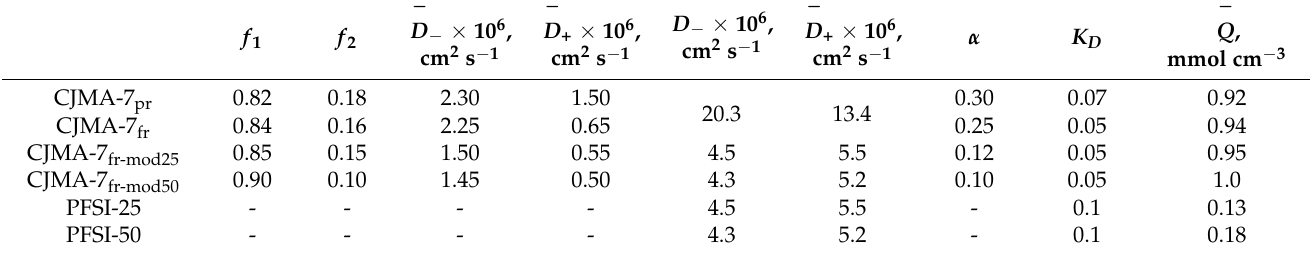
Table 1. Parameters of the MH model for the studied membrane samples in NaCl solution. PFSI-25 and PFSI-50 denote the PFSI material in the cases where the modified membrane was dried at 25 ◦ C and 50 ◦ C,